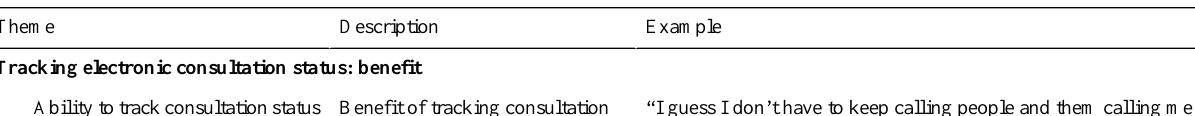
Table 4. Parent perspectives on parent participation in electronic